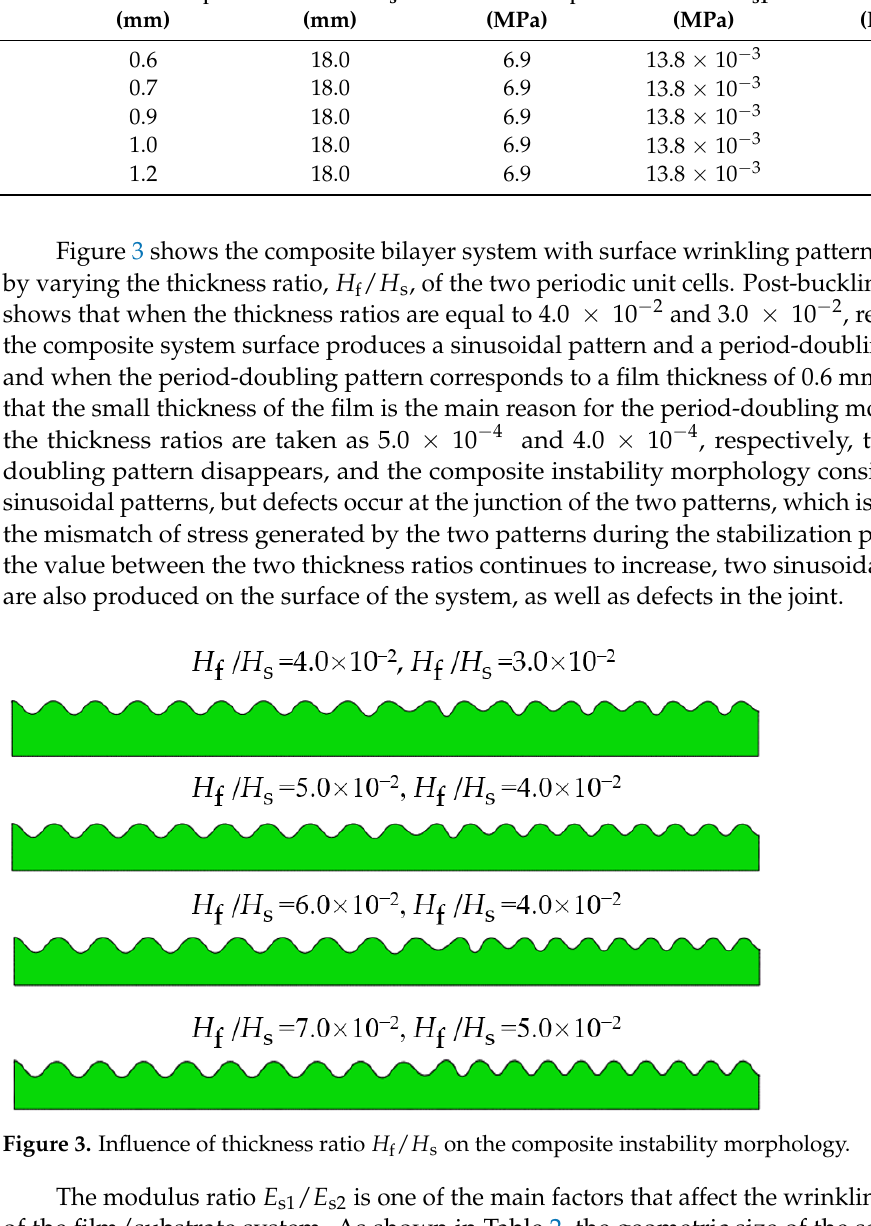
Table 1. Different thickness ratios, H f / H s .